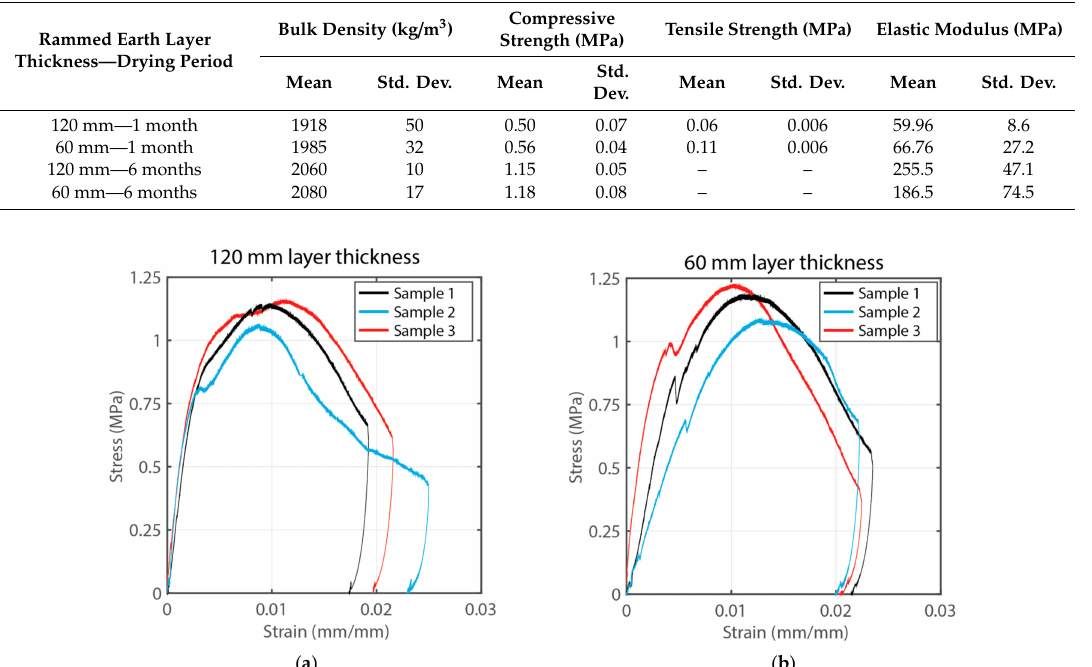
Table 1. Material properties of rammed earth from material characterization tests.